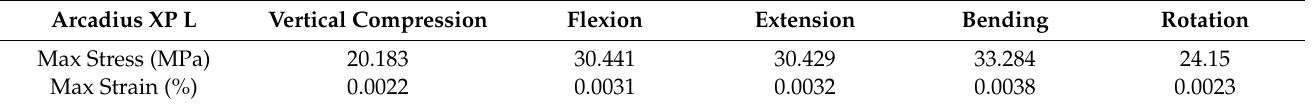
Table 17. The max stress and strain of the Arcadius XP L